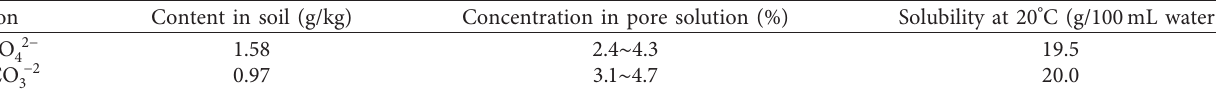
Table 2: Detection and sampling results in the western Jilin